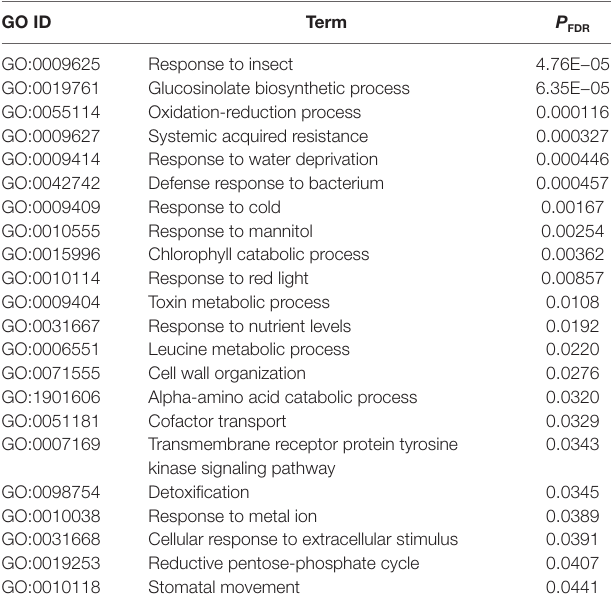
TABLE 2 | Gene ontology (GO) enrichment analysis of genes with the top 5% of expression variation explained by plant accessions. P -values are corrected by the false discovery rate ( P FDR ). Shown are the significant GOs within the biological process terms ( P FDR < 0.05).